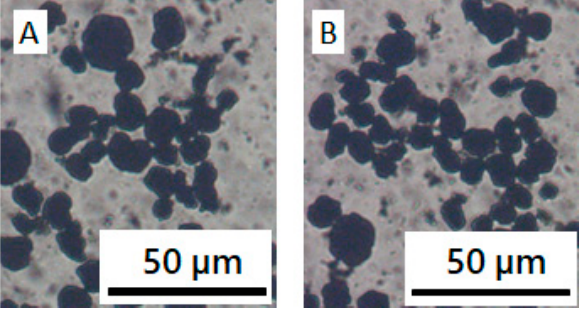
Figure 8. Microscope images of NCM and CB in PVDF/NMP solution with a varying φ PVDF . ( A ) 0 wt%, ( B ) 2.5 wt%.